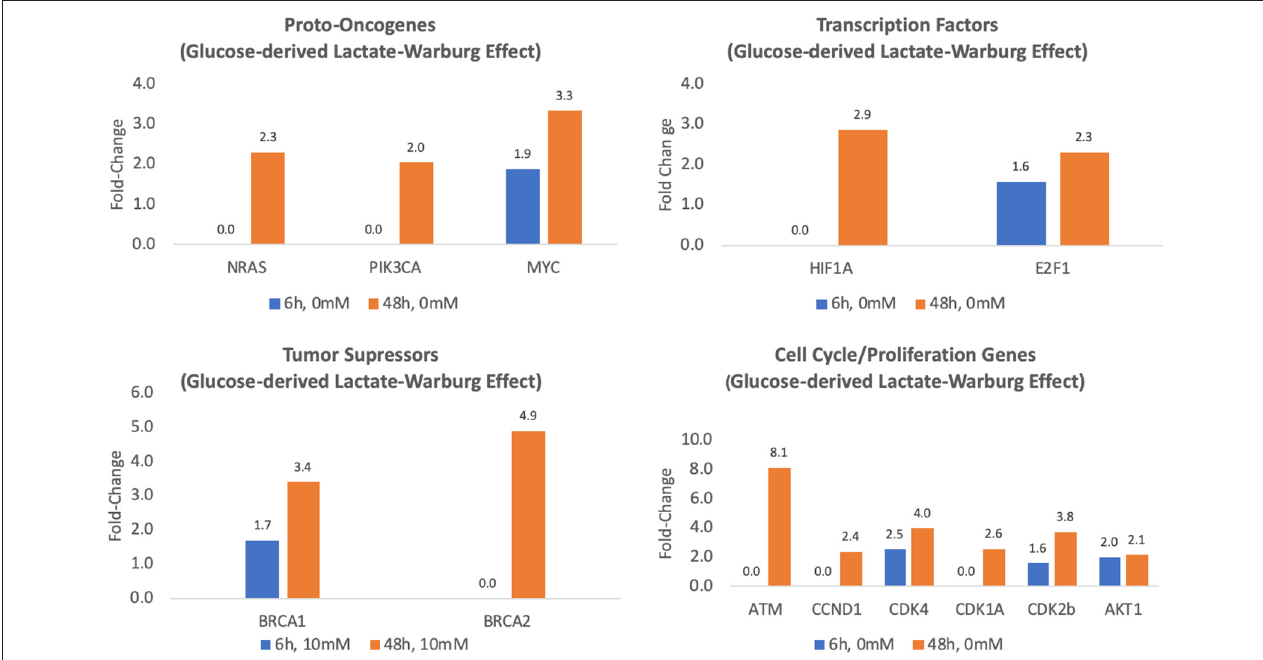
FIGURE 2 | Fold-regulation of Glucose-derived lactate (Warburg Effect) transcriptional activity for MCF7 cells cultured for 6 and 48h in glucose media relative to controls (MCF7 cells cultured in glucose/glutamine-free media) ( p ’s ≤ 0.05–0.01).